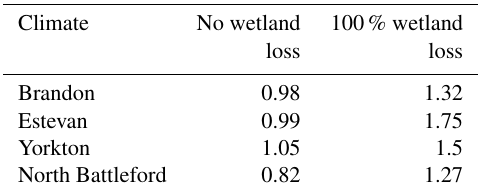
Table 7. Coefficient of variation in annual runoff for the period of simulation